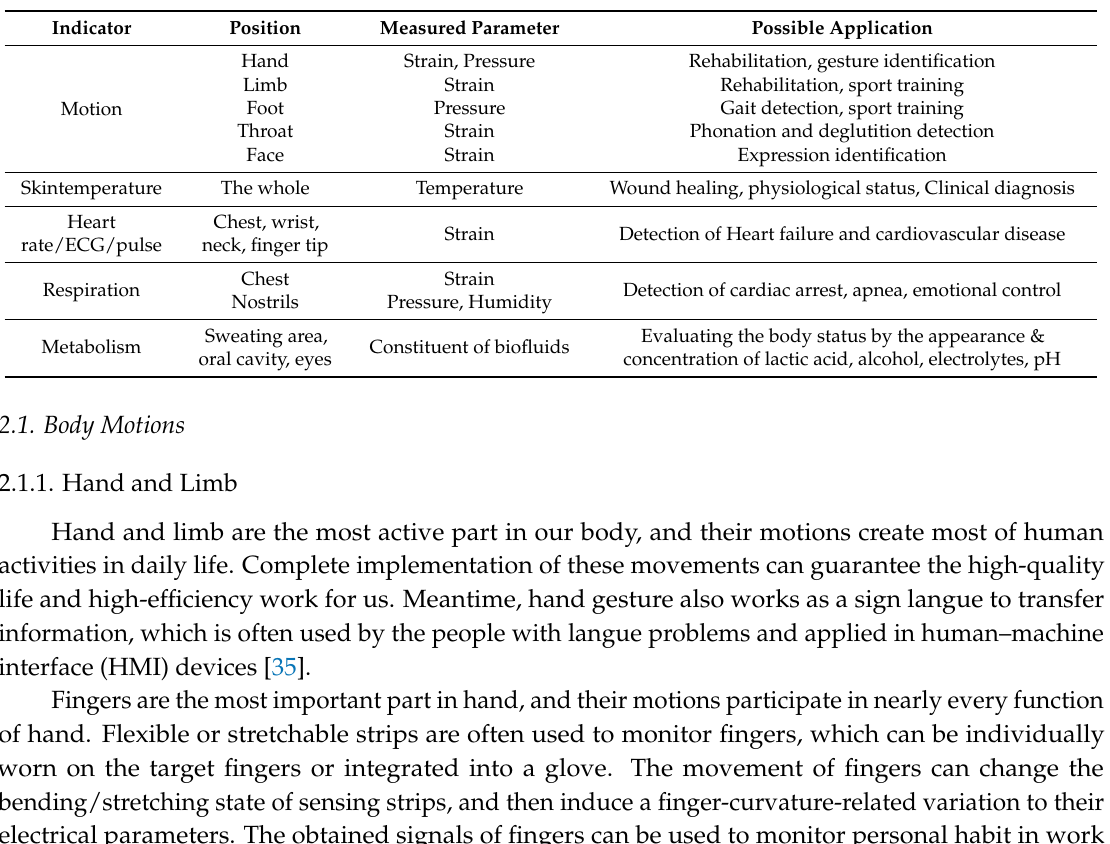
Table 1. Detectable indicators in health